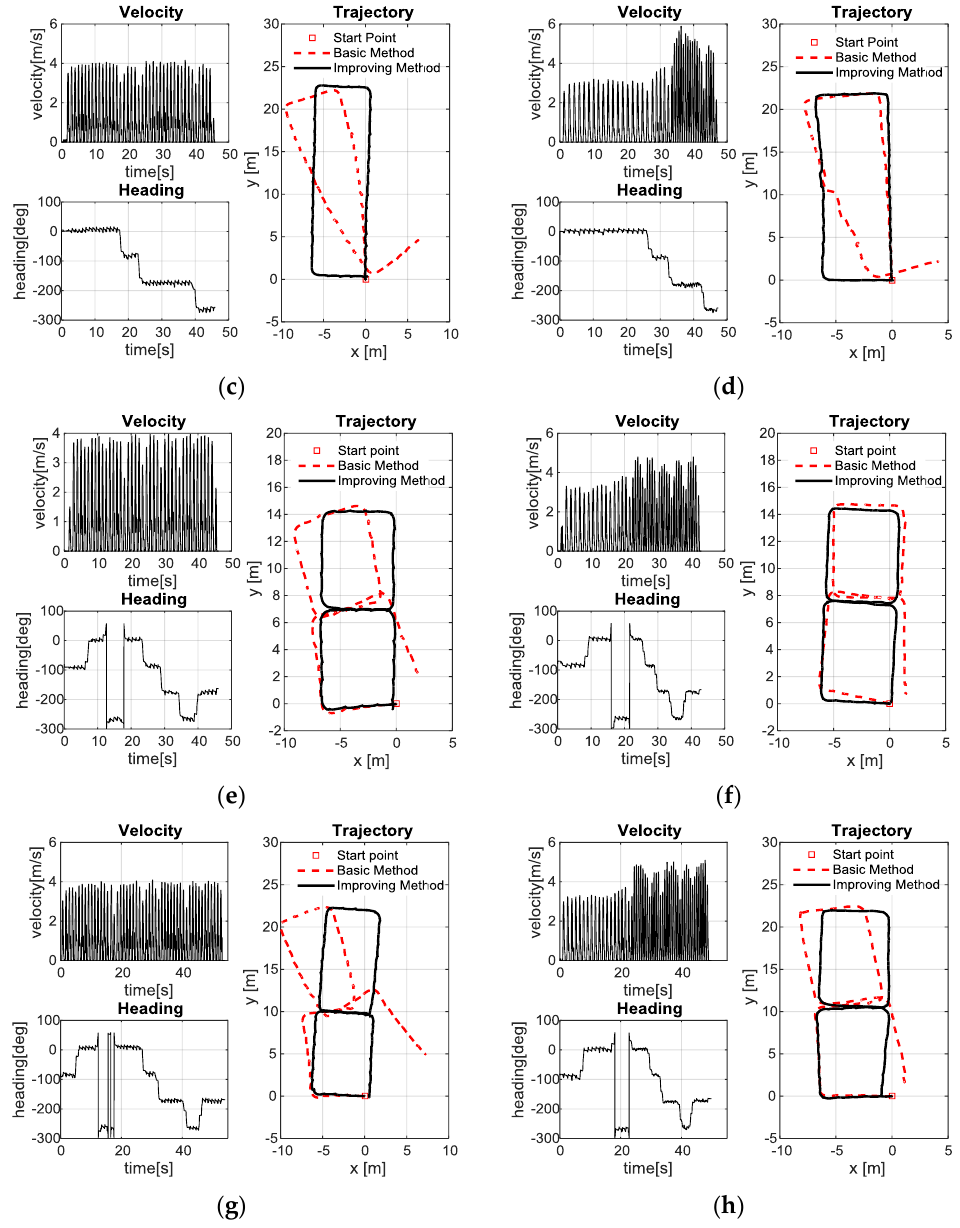
Figure 11. Pedestrian-positioning test results: ( a ) Test 1; ( b ) Test 2; ( c ) Test 3; ( d ) Test 4; ( e ) Test 5; ( f ) Test 6; ( g ) Test 7; ( h ) Test 8.